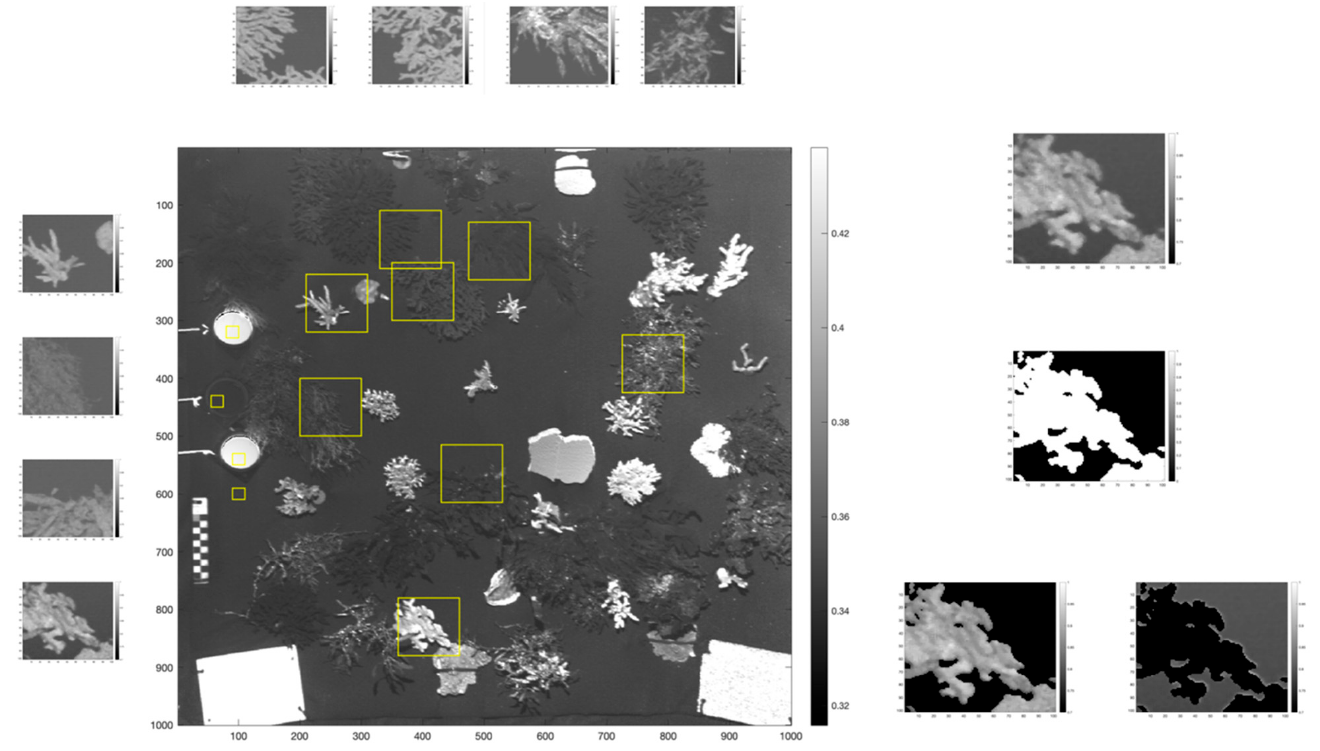
Figure 10. Contrast Ratio (CR) and Contrast Signal − to − Noise − Ratio (CSNR) macroalgae and coral subsample locations (large yellow squares), as well as reflectance standard subsets (small yellow squares. Macroalgae and coral specimen subsets are shown vertically to the left and top of the main center image. To the right of the main image, coral subsets (top right) are shown, with binary selection filter (from image pixel fluorescence threshold value) (middle right), and programmatically (binary fluorescence filter) selected fluorescent (to right of main image, left subset) and non-fluorescent background (to the right of main image, right subset).